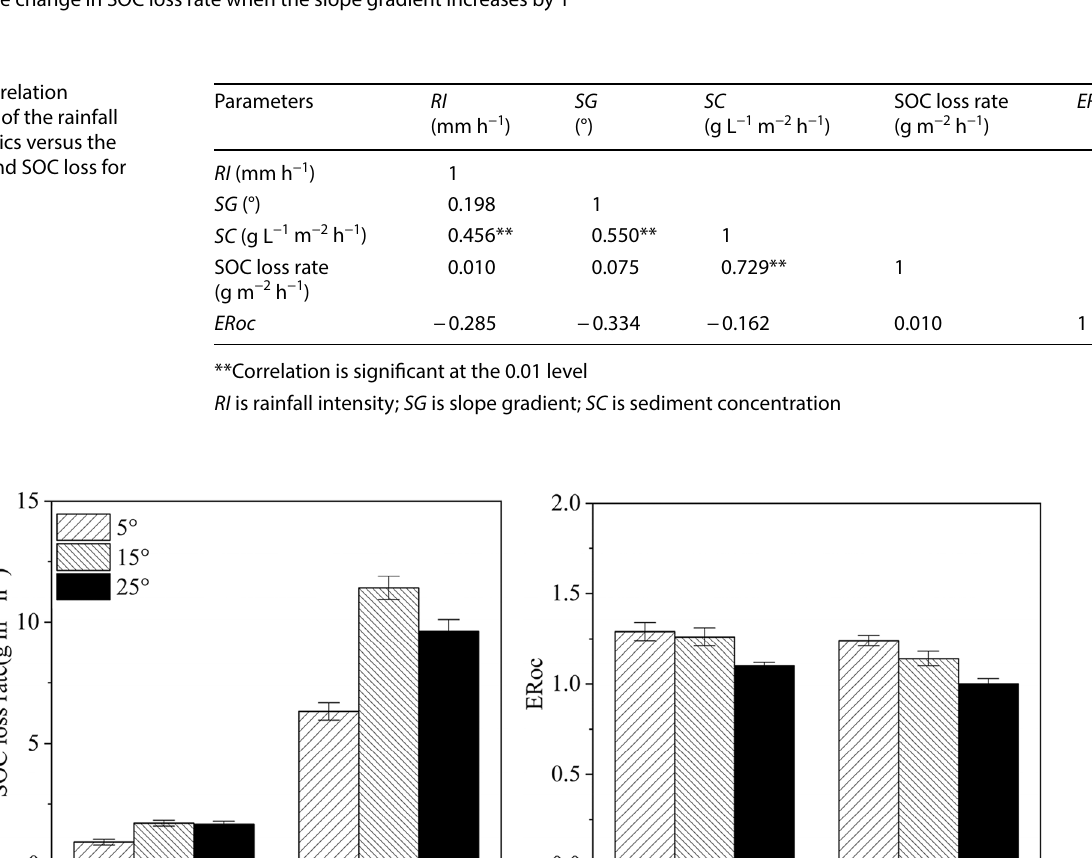
Table 3 Correlation coefficients of the rainfall characteristics versus the sediment and SOC loss for three soils